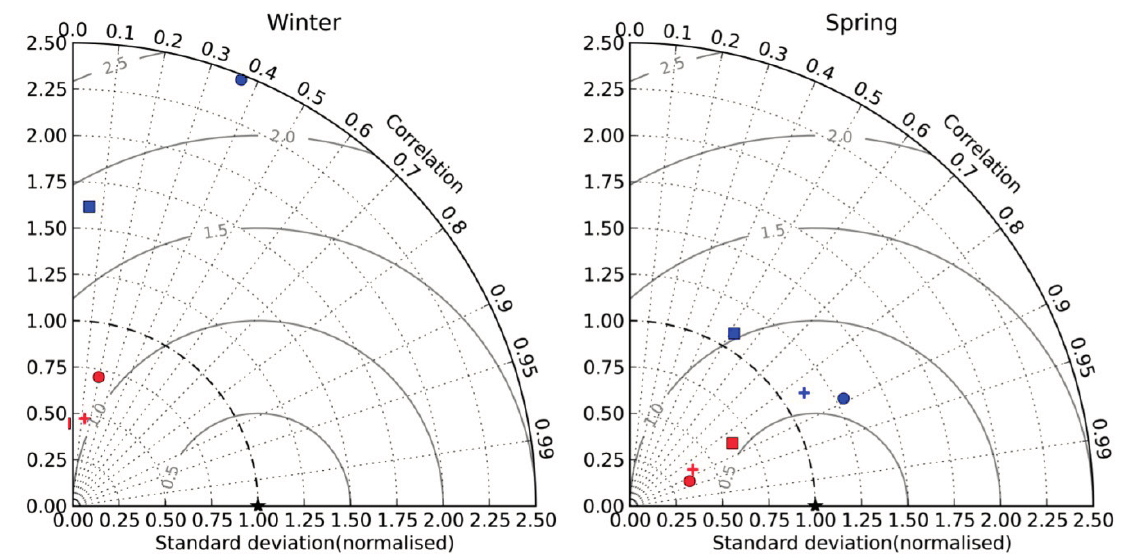
Figure 4. Taylor diagrams illustrating the remote sensing soil moisture product statistics against the in situ observations. While the seasonal ECV SM values are less variable than the in situ records (left side of the dotted arc), the ASAR SM data exhibit a larger variability (right side of the dotted arc). By comparing both the satellite datasets with the ground measurements, it has been found that the highest correlation occurs in spring and autumn. On the contrary, in the extremely wet conditions in winter or relatively dry summer seasons, a very poor agreement has been found between both ASAR and ECV SM time series and ground